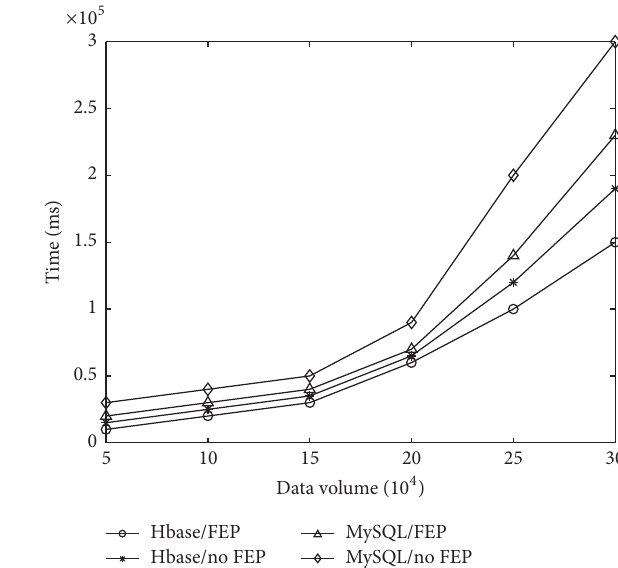
Figure 8: Running time of CDSS in various